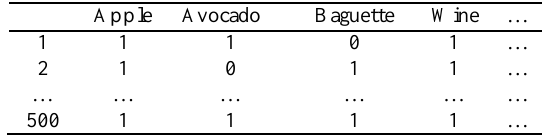
Table 1. Recording statistics of customer consumption in a supermarket